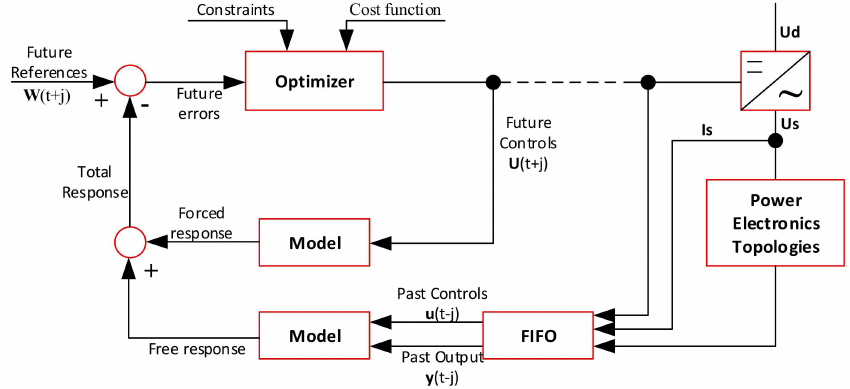
Figure 12. General structure of an MPC controller.